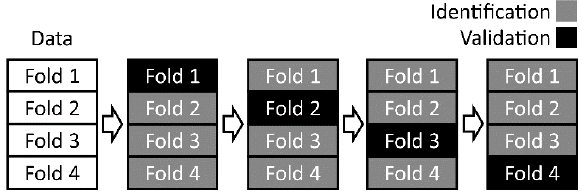
Figure 2. The principle of the applied 4-fold cross-validation method. Measurement data is divided into four folds of equal lengths and one is used for the validation while the other ones are merged as an identification data for the parameter estimation. Model structures with delays that range from one to eight hours for heating power were investigated including two and three power value combinations. These amounted to 92 model structure variations to be identified and validated with data from every building with all the available indoor temperature measurements and three constant C values. This resulted in total of 7176 different cross-validation runs. An overview of the identification and validation process is presented in Figure 3.